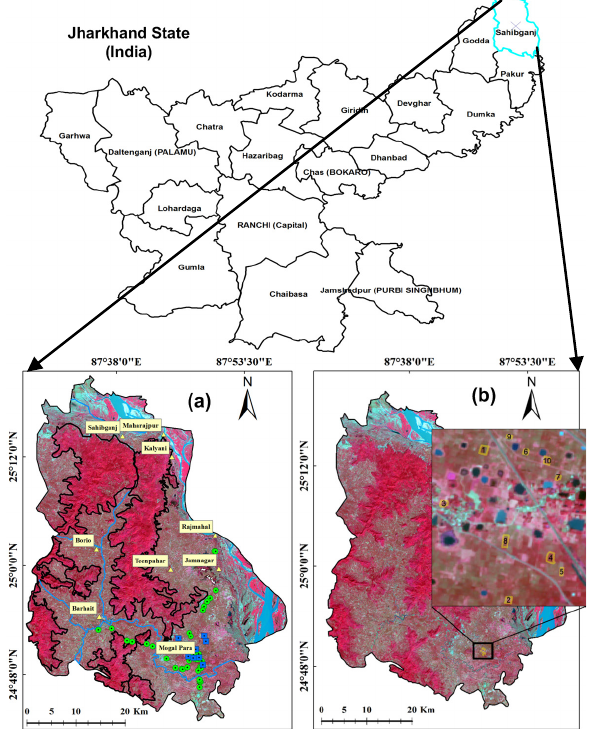
Figure 1. Location map of the study area (a) with GPS points of paddy plots (green colour) and the farmers-based APY data (cretan blue), in (b), ten CCE plots were shown.